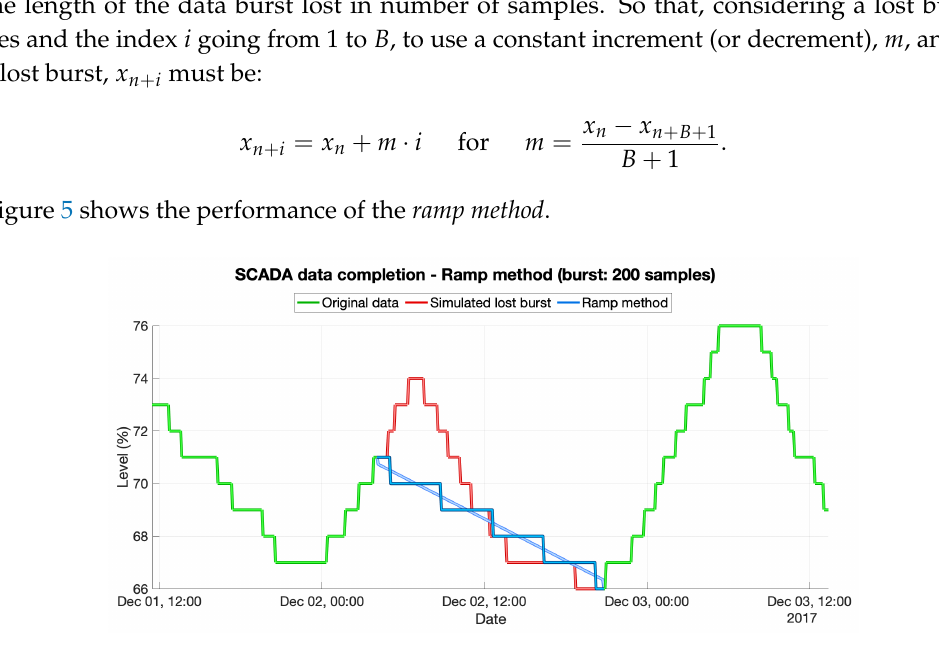
Figure 5. The ramp method . The red line shows the burst of the simulated lost data. The blue line corresponds to the data reconstruction of the linear method called the ramp method . The soft blue line shows the linear method result and the strong blue line shows the final signal reconstruction, which is adapted to the sensor resolution of